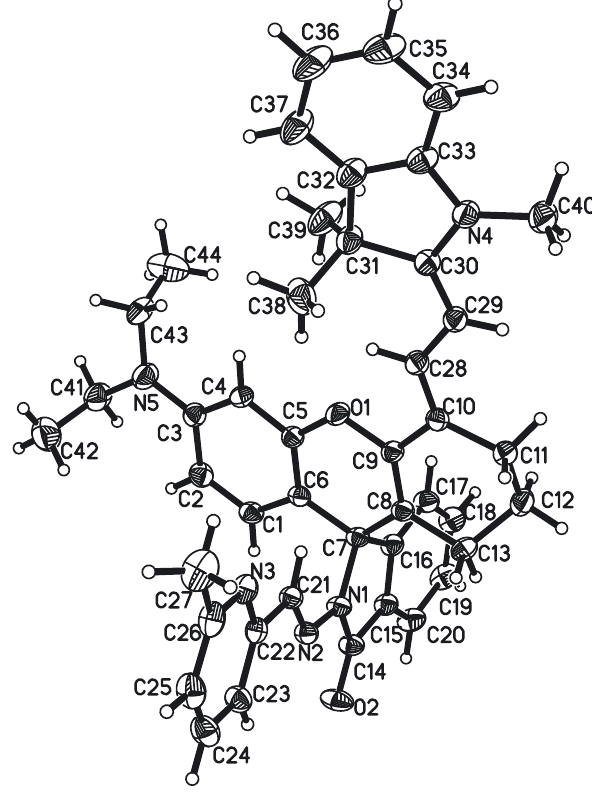
Table  : Data collection and